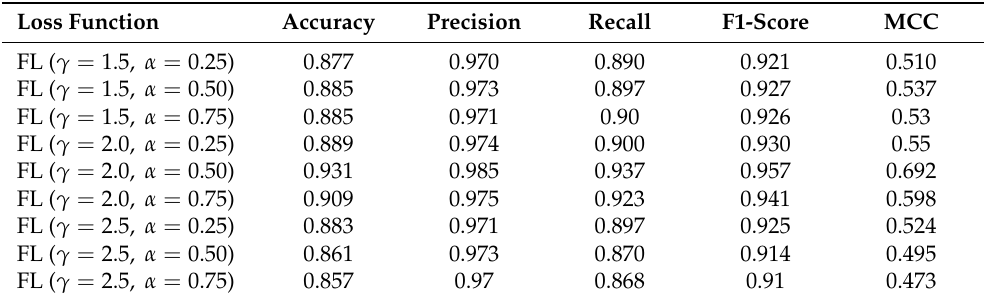
Table 6. Classification results with HSI-30 dataset for varying cost functions and respective parameter sets. (patch size parameter S = 100, 3D convolutions, see Figure A2 for network topology).